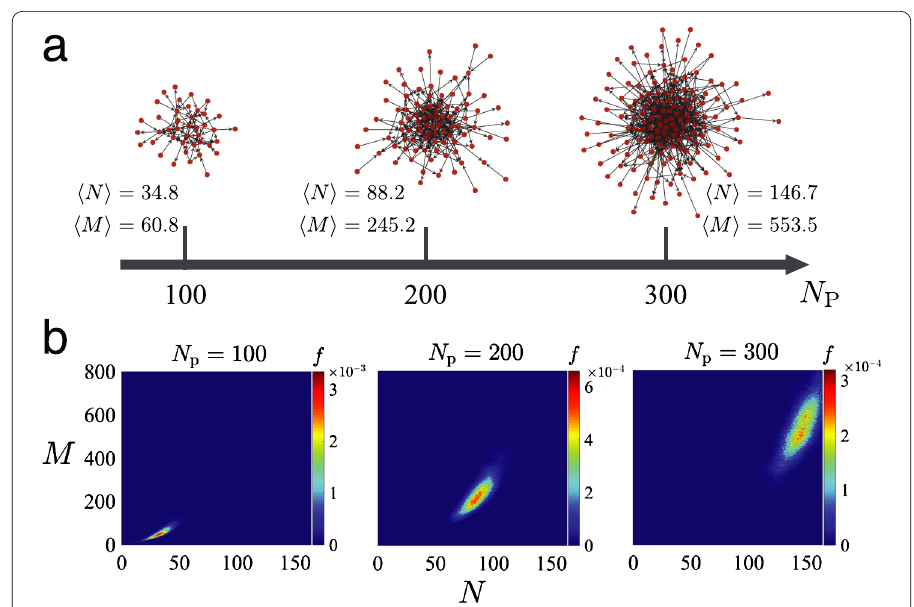
Figure 5 Generation of model networks. ( a ) Model networks with N P = 100,200, and 300 (visualized by graph-tool [65]). The average values (cid:6) N (cid:7) and (cid:6) M (cid:7) for each N P are also shown. ( b ) Joint conditional probability function f ( N , M | N P ) (color bar) for a given N